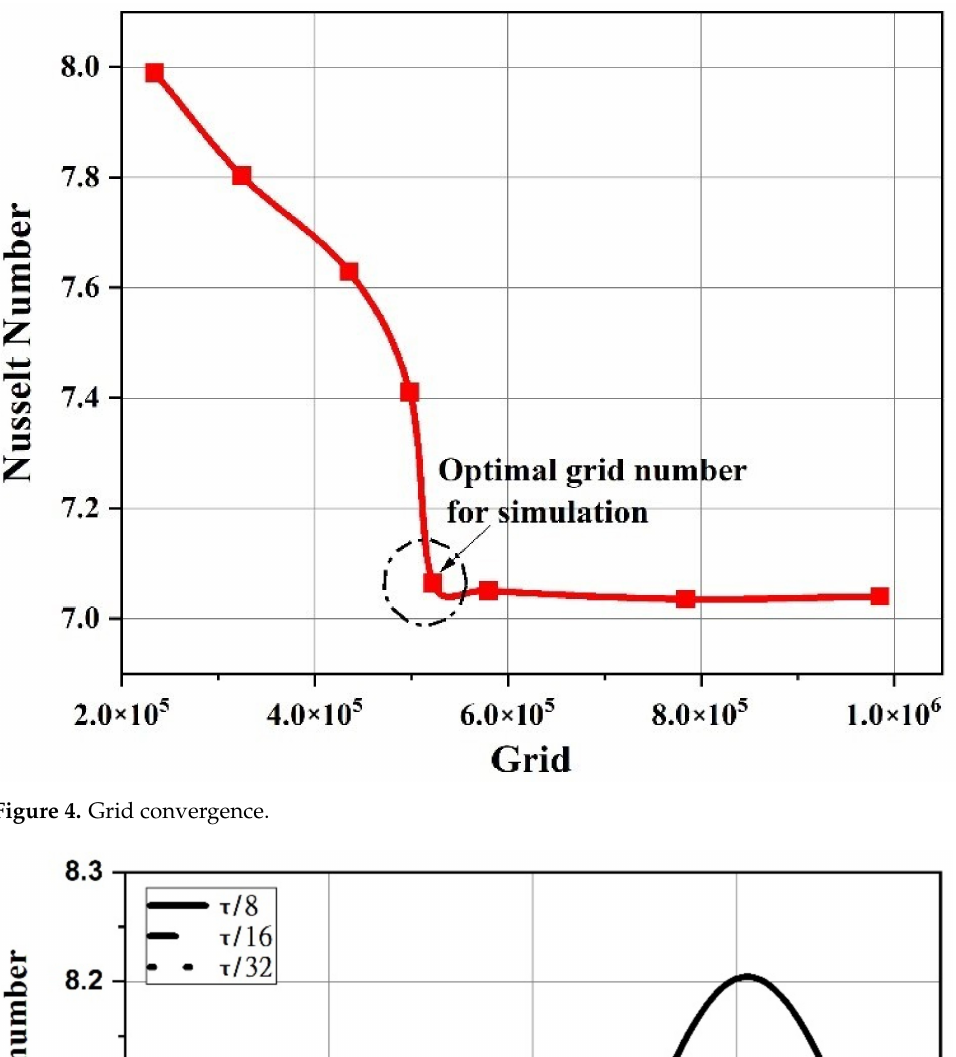
Figure 4. Grid convergence.